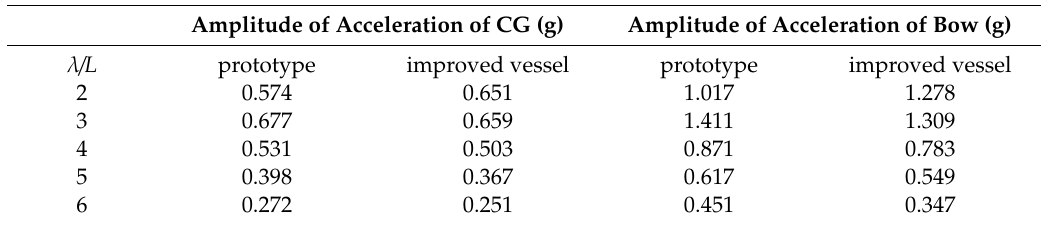
Figure 16 indicates that the motion tendency of the prototype and improved vessel are similar: As the wave length increased, the amplitudes of the pitch and acceleration began to decrease gradually after reaching the resonance region, while the amplitudes of heave tend to remain